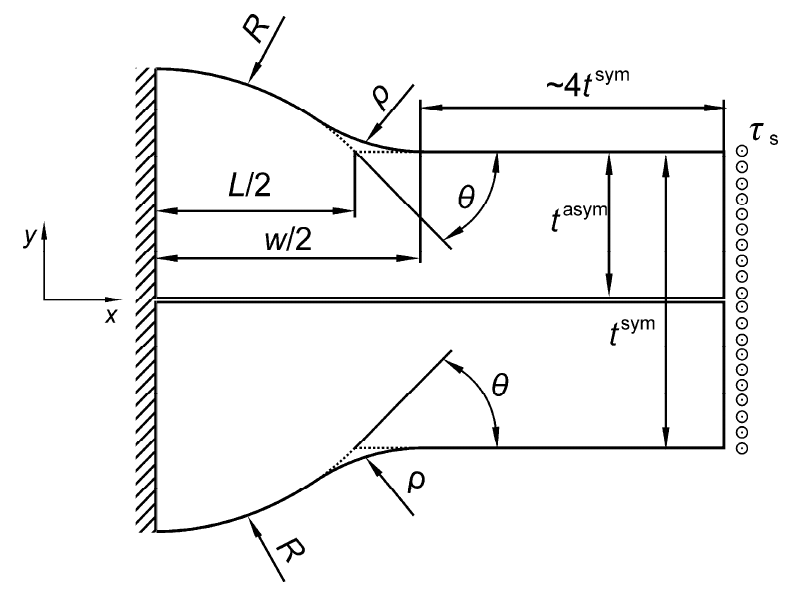
Figure 9. Boundary conditions for a Single–V and Double-V, butt-welded joint subjected to shear.